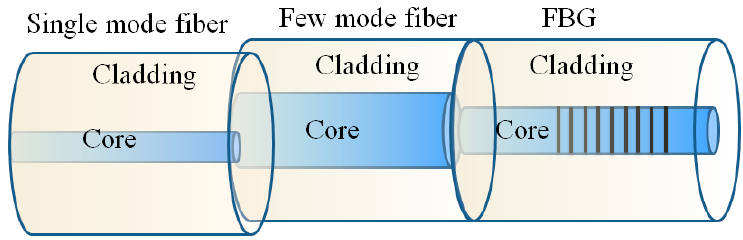
Figure 13. Sensing configuration for strain and temperature monitoring.